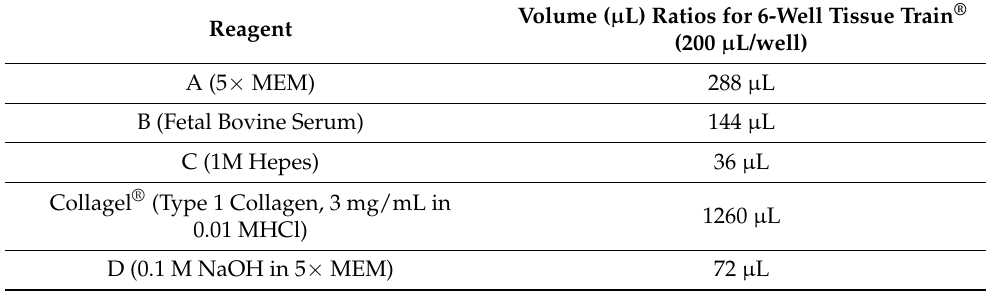
Figure 1. Flexcell Bioflex and Tissue Train models. ( A ) Image of a 6-well bioflex 6-well culture plate with a flexible membrane bottom and a schematic showing a 2D monolayer of cells grown in the plate. ( B ) Image of a 6-well tissue train culture plate placed on a loading post with the groove in which 3D collagen gels are made. A schematic showing the application of uniaxial strain on a linear fibroblast-seeded 3D collagen gel through the application of vacuum pressure underneath the loading post. ( C ) A schematic showing the production of fibroblast-seeded 3D linear gels in the Tissue train system before the application of strain. Adapted from Garvin et al. [24] and Flexcellint ® . Table 1. Volumes of Collagel ® kit components, as standardized by Flexcellint ®.